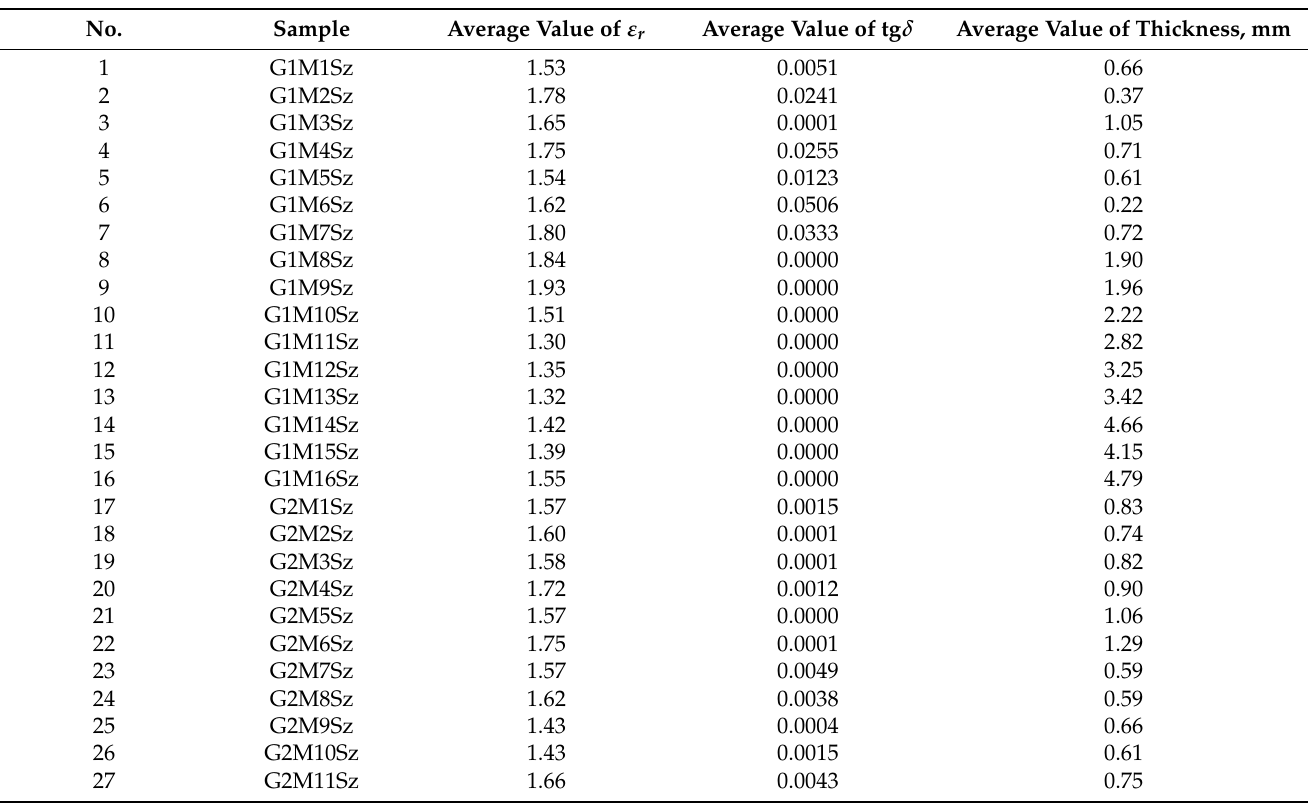
Table 12. Parameters of substrates considered in